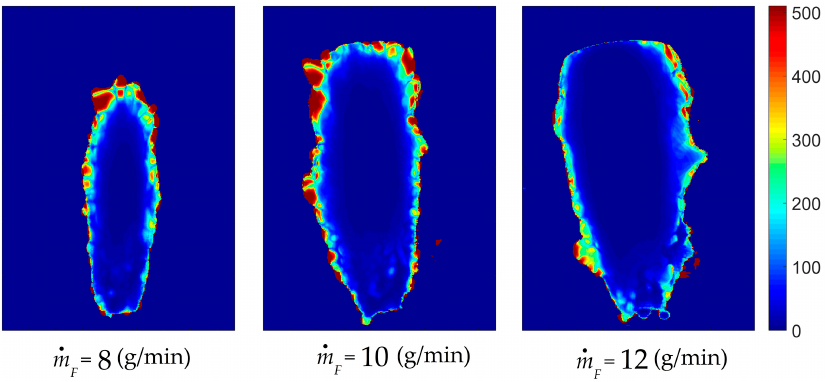
Figure 8. The distribution of kurtosis for the mass flow rate of fuel.